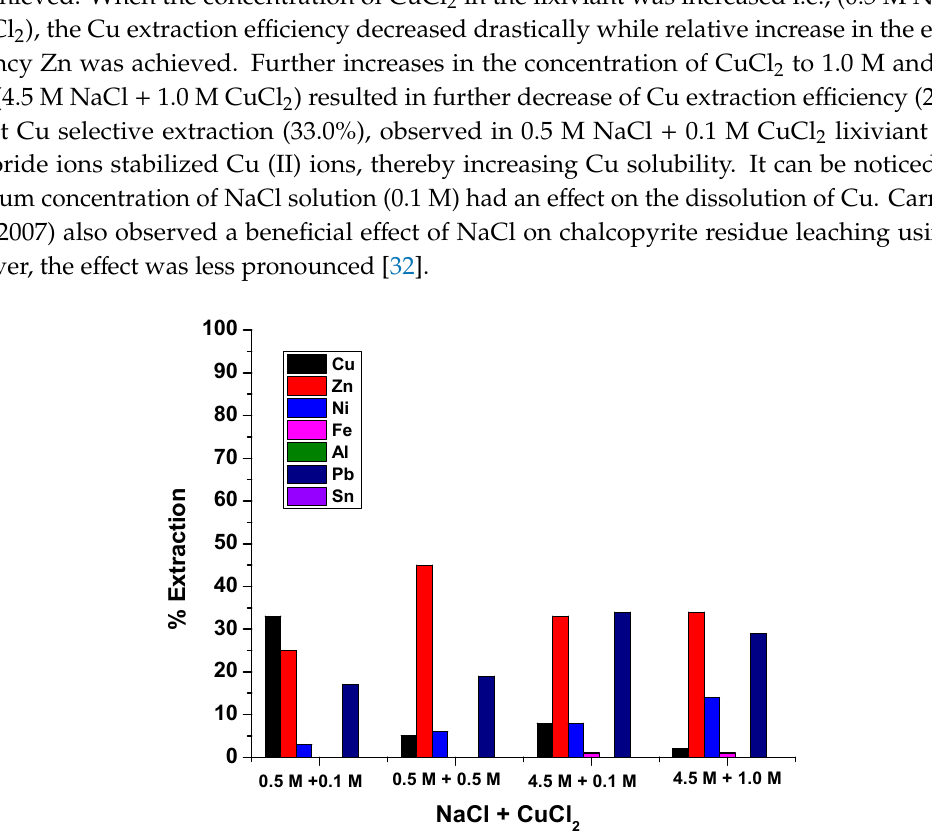
Figure 8. Comparative extraction e ffi ciencies of Cu and Zn, and the co-extraction of other metals from WPCBs using NaCl + CuCl 2 lixiviant, 50 g / L pulp density, 25 ◦ C, 300 rpm, and 12